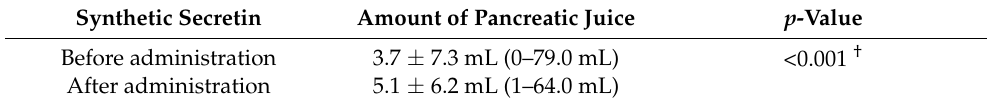
Table 4. Comparison of pancreatic juice quantity before and after synthetic secretin administration. Synthetic Secretin Amount of Pancreatic Juice p